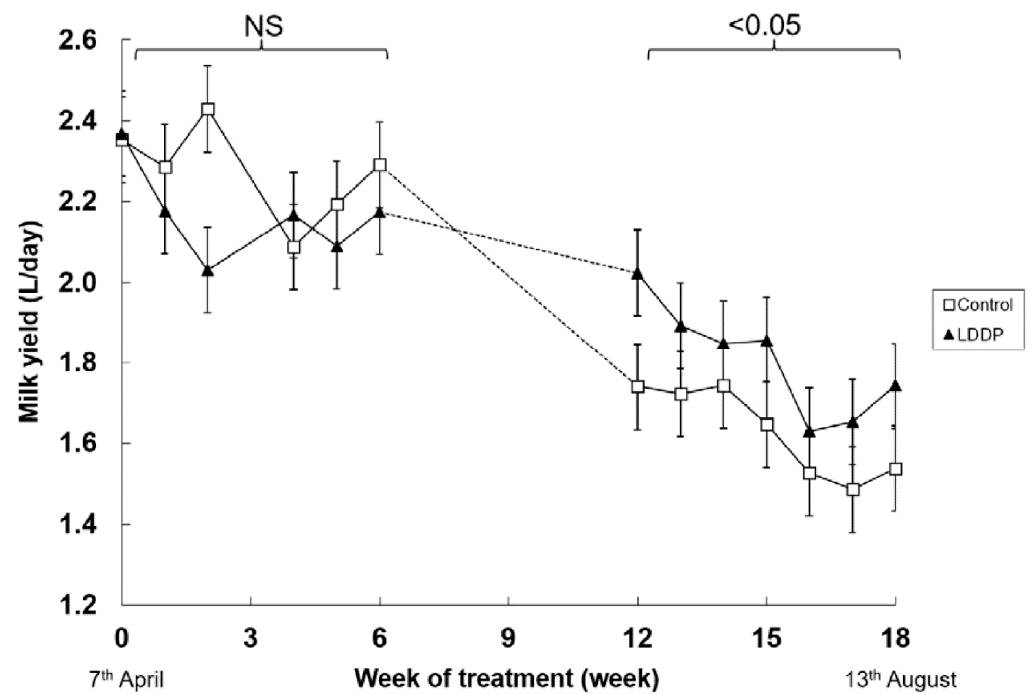
Figure 1. Effect of ambient lighting (Control) or long day photoperiod (LDPP) on milk yield in lactating goats in winter in the Southern Hemisphere. Data are means ± standard error of the difference for the interaction between treatment and week. NS: no significant.